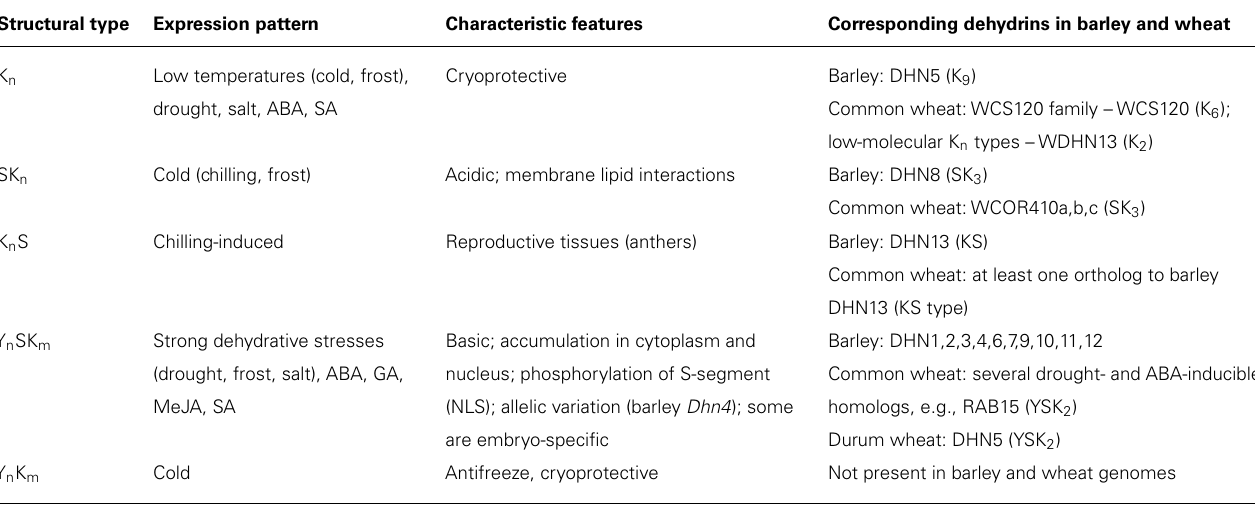
Table 1 |An overview of dehydrins in barley ( Hordeum vulgare ), common wheat ( Triticum aestivum ), and durum wheat ( Triticum durum ) listed according to their structural types described in Close (1997) including their expression patterns as well as characteristic features. Structural type Expression